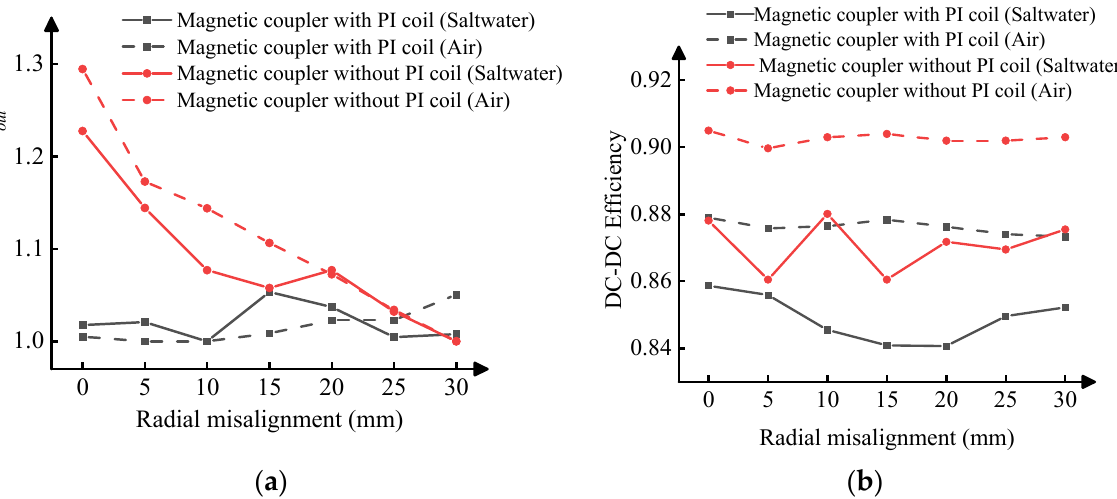
Figure 17. The output power and system efficiency varying with radial misalignments when h = 50 mm: ( a ) normalized output power; ( b ) system efficiency.